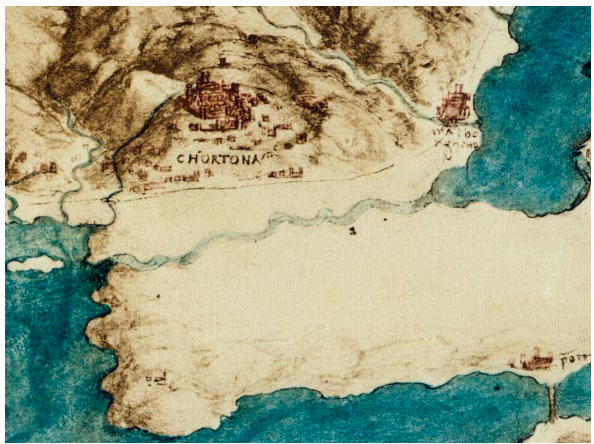
Figure 5. Detail of the “Trasumeno” from the Map of Valdichiana , Windsor, Royal Library, 12278r.